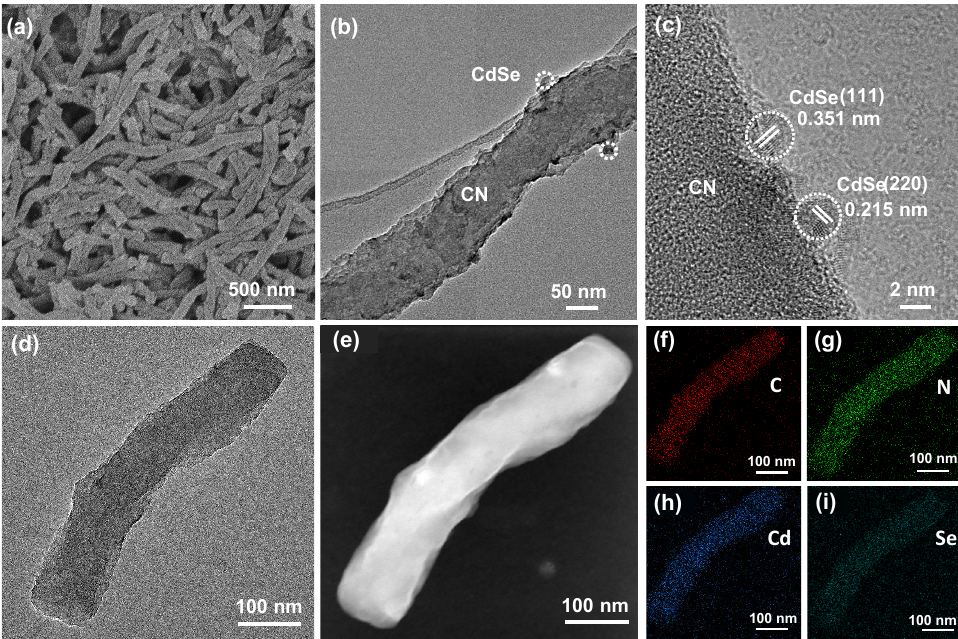
Figure 2. ( a ) SEM, ( b – d ) TEM and HRTEM images, ( e ) HAADF-STEM images, and TEM element mapping images of ( f ) C, ( g ) N, ( h ) Cd, and ( i ) Se of 5% CdSe/CN.